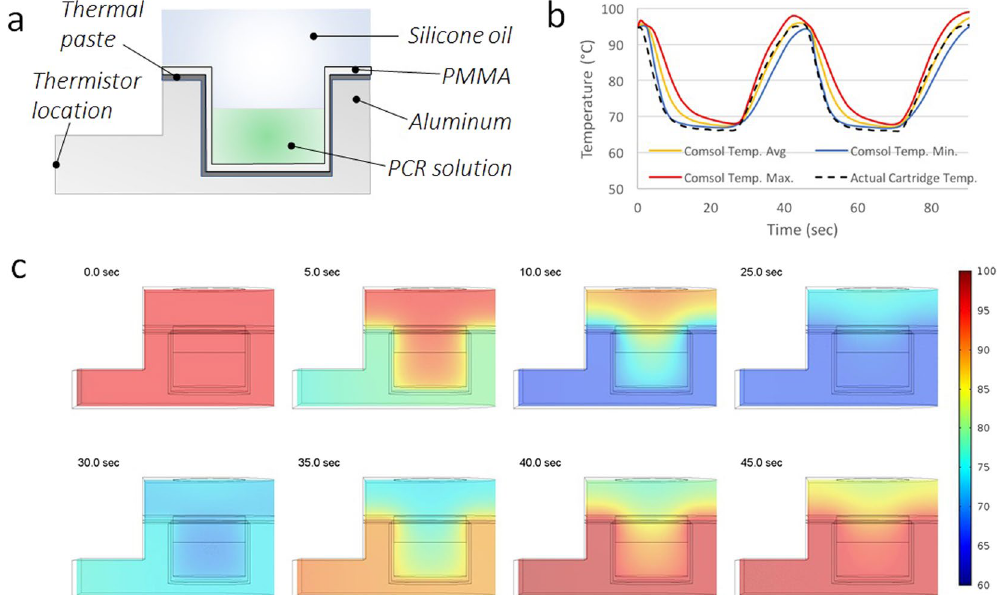
Figure 4. PCR Thermal Cycling Characterization. ( a ) Cross-sectional schematic of the aluminum heat block with inserted PCR well of thermoformed cartridge. Thermally conductive paste was used to ensure complete contact and heat transfer between the heat block and cartridge. ( b ) Comparison of maximum, average, and minimum temperature of the PCR solution tracked during finite-element COMSOL simulation versus actual temperature measured by a separate thermistor directly within the cartridge well during thermal cycling. ( c ) Temperature heat-map snapshots from cross-section of the finite-element simulation. The top row follows cooling from a uniform temperature of 95 °C while the bottom row shows the heating back to 95 °C. Uniform temperature distribution within ~1 °C of the target annealing and denaturation temperatures is evident throughout the entire PCR solution delineated by the rectangle at the bottom of the well at the end of each heating and cooling